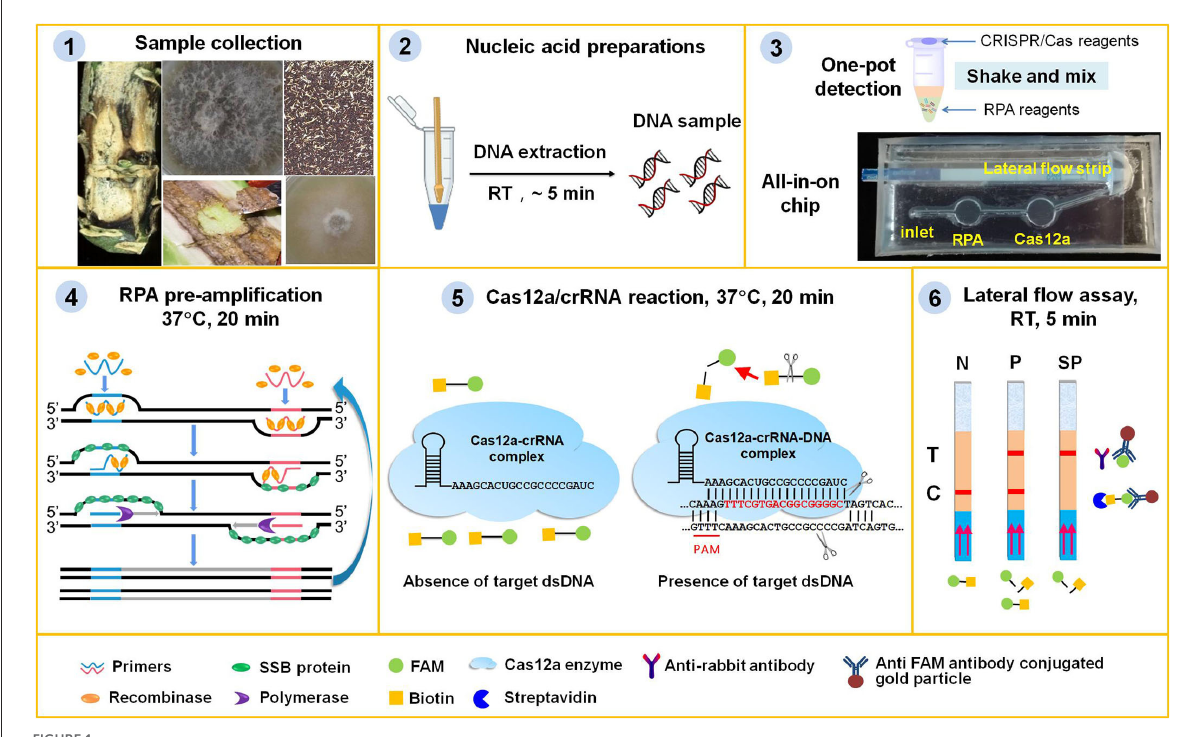
FIGURE1 Principle of the RPA/Cas12a-based portable platform for the detection of plant fungi. (1) Plant tissues, such as stems with black canker symptoms, leaves with phoma leaf spotting, wizened oilseed rape seeds or residues with black spots, or fungi hyphae were collected from samples in field or at port. (2) Plant tissues or fungal hyphae were ground with quartz sands and plastic pestle to mud or powder, and the DNA was extracted with fast nucleic acid release reagents. (3) Lyophilized RPA pre-amplification reagents (containing the enzymes, primers, probe, and buffers), and Cas12a reagent mixture (containing crRNA, cas12a enzyme, and reaction buffer) were pre-stored in one tube or the chambers of the chip. (4) The fungi genomic DNA was pre-amplified with RPA enzymes and primers at 37 ◦ C for 20min. (5) The RPA pre-amplification products were detected with CRISPR/Cas12a system at 37 ◦ C for 20min. When the RPA products contained the target DNA, the binding of Cas12a/crRNA to target DNA would initiate its ability to digest reporter ssDNA with biotin and FAM group. (6) The intact ssDNA reporter was captured by the streptavidin on lateral flow strips to form control band, or else the cleaved FAM group binding with the FITC antibody conjugated gold particles moved to the test band. The lateral flow assay was complete within 5min, and the bands could be immediately visually observed. N, negative sample; P, positive sample; SP, strong positive